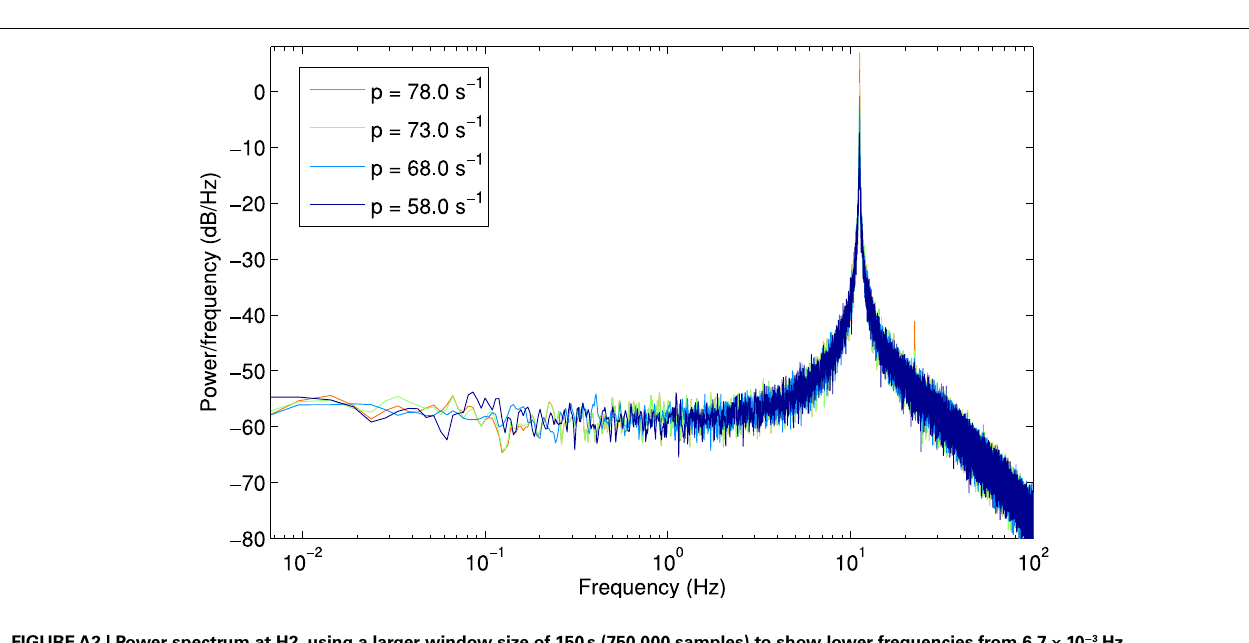
FIGUREA2 | Power spectrum at H2, using a larger window size of 150s (750,000 samples) to show lower frequencies from 6.7 × 10 − 3